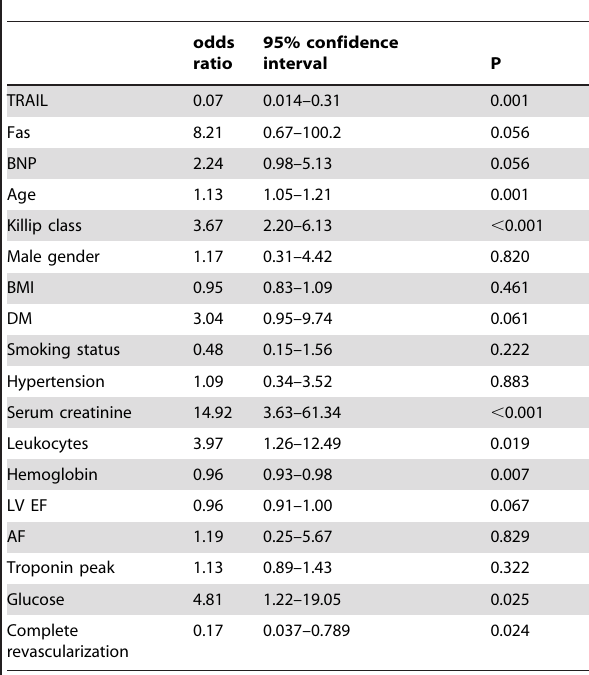
Table 2. Univariate analysis of predictors of combined end- point (death or hospitalization for heart failure).